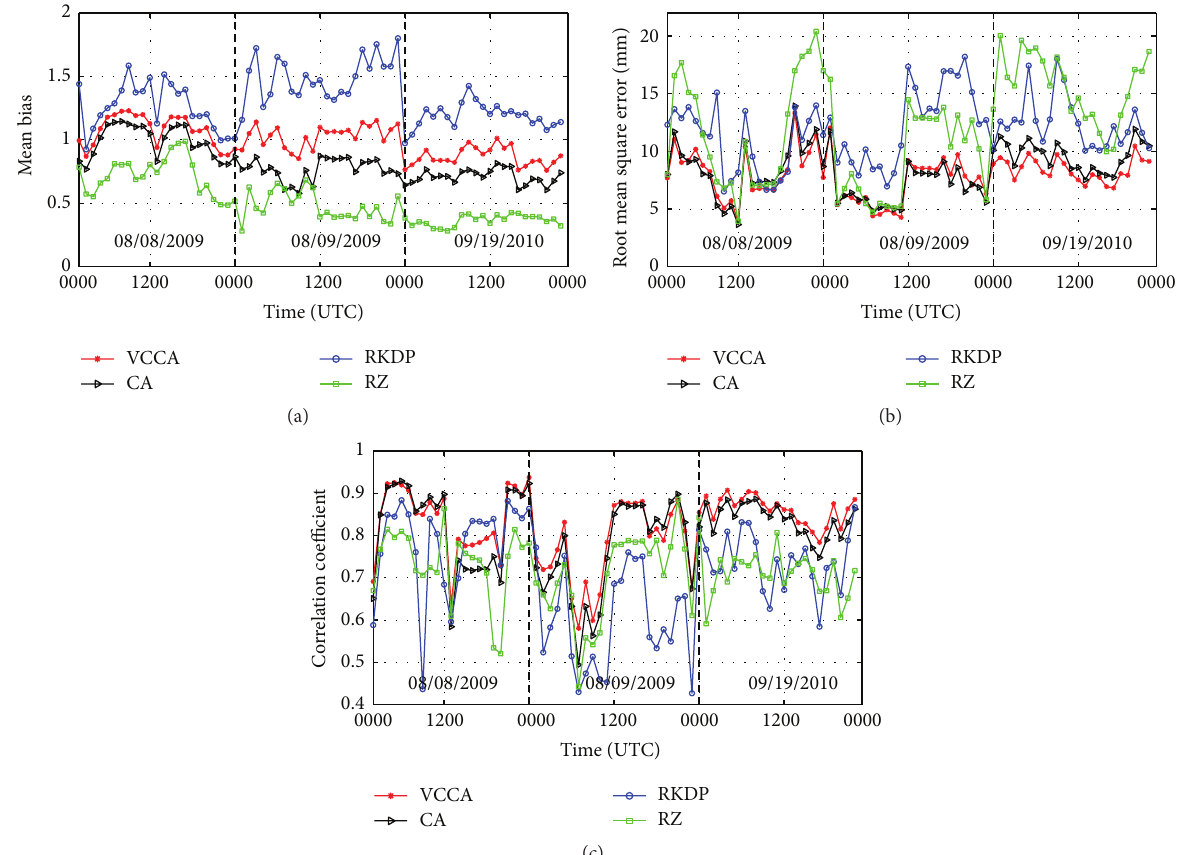
Figure 9: The time series plots of mean bias (a), root mean square error (b), and correlation coefficient (c) using these four approaches.